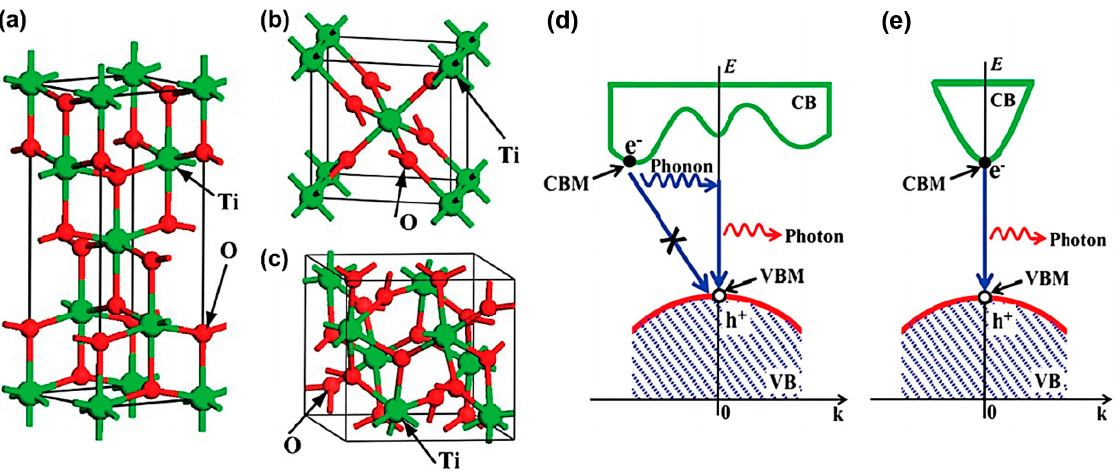
Figure 5. Atomic structure of ( a ) anatase TiO 2 , ( b ) rutile TiO 2 , and ( c ) brookite TiO 2 . Green and red balls represent Ti and O atoms, respectively. Schematic carrier recombination process in ( d ) anatase and ( e ) rutile TiO 2 . The e − and h + represent the photogenerated electron and hole, respectively. Reproduced from [27] with permission from the PCCP Owner